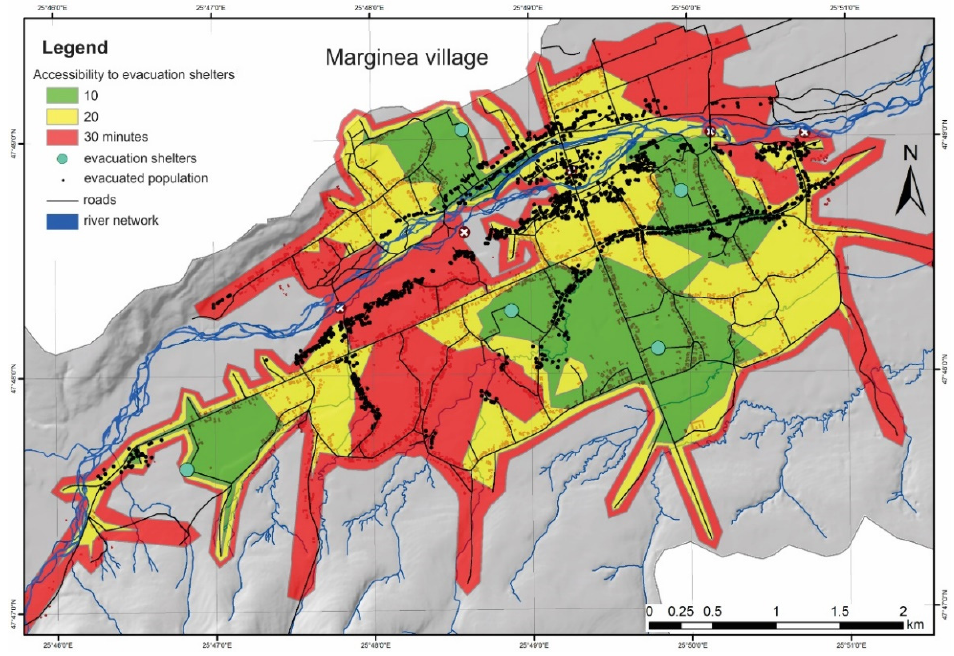
Figure 8. Coverage areas with evacuation service for Marginea village.